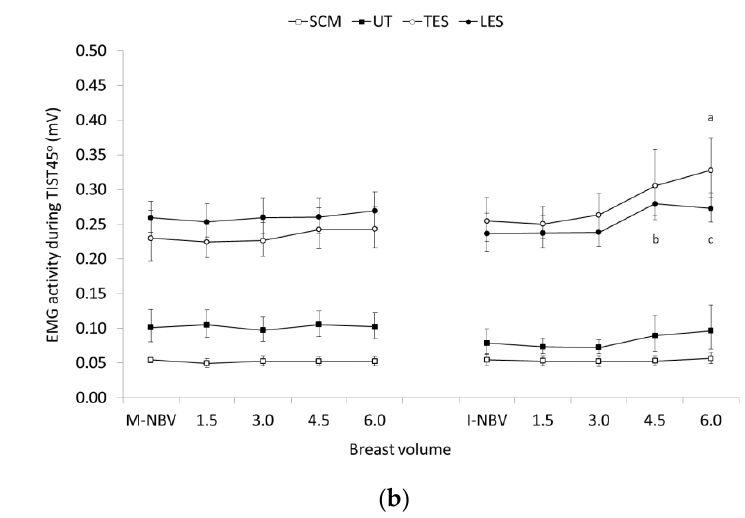
Figure 2. ( a ) The trunk inclination at 45° from the upright standing posture (TIST45°); ( b ) Geometric means and confidence intervals (error bars) of the sternocleidomastoid (SCM), upper trapezius (UT), and thoracic and lumbar erector spinae (TES and LES) EMG activity in females with minimal and ideal natural breast volume (M-NBV, I-NBV) as well as with increased NBV by 1.5-, 3.0-, 4.5- and 6.0-times during TIST45°. a significant different (SD) compared to I-NBV (p < 0.001), 1.5- ( p < 0.001) and 3.0-times the I-NBV ( p < 0.05) for TES; b SD compared to I-NBV ( p < 0.01), 1.5- ( p ≤ 0.05) and 3.0- times the I-NBV ( p ≤ 0.05) for LES; c SD compared to I-NBV ( p < 0.05), 1.5- ( p ≤ 0.001), and 3.0-times the I-NBV ( p ≤ 0.05) for LES.